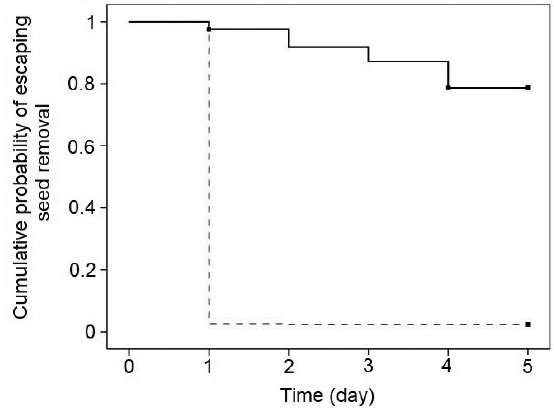
Figure 2. Probability of escaping seed removal (escape curves) for E. lobata seeds exposed to bird (solid line) and mammal granivores (dotted line).